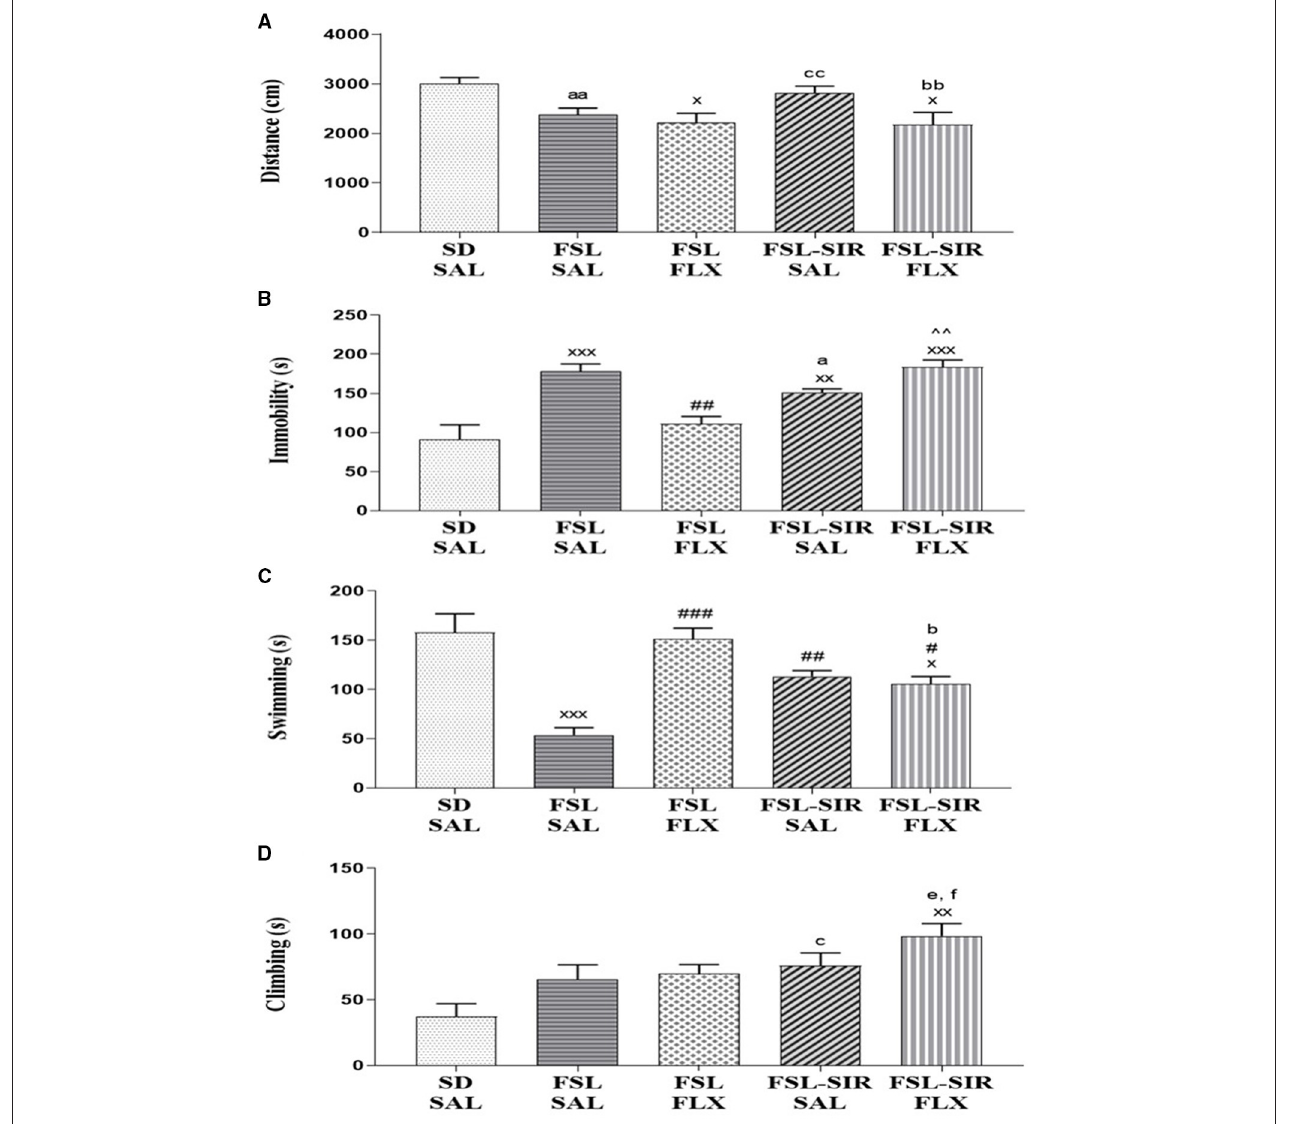
FIGURE 3 | (A) Locomotor activity measured as distance travelled in the open field test (OFT). x p < 0.05 vs. SD-SAL; aa d = 1.5 vs. SD-SAL, cc d = 0.9 vs. FSL-SAL; bb d = 1.0 vs. FSL-SIR-SAL. (B-D) Immobility and swimming and climbing behaviours as measured in the forced swim test (FST). (B) Immobility (s). xxx p < 0.0001, xx p < 0.01 vs. SD-SAL; ## p < 0.01 vs. FSL-SAL; ∧∧ p < 0.01 vs. FSL-FLX; a d = 1.1 vs. FSL-SAL. (C) Swimming (s). xxx p < 0.0001, x p < 0.05 vs. SD-SAL; ### p < 0.0001, ## p < 0.01, # p < 0.05 vs. FSL-SAL; b d = 1.5 vs. FSL-FLX. (D) Climbing (s). xx p < 0.01 vs. SD-SAL; c d = 1.2 vs. SD-SAL, f d = 1.0 vs. FSL-SAL, e d = 1.0 vs. FSL-FLX. Data were analysed using two-way ANOVA followed by Bonferroni post hoc test and Cohen’s d analysis. Data are presented as mean ± SEM. Detailed p –values in the text. FSL, Flinders’ Sensitive Line; FLX, fluoxetine; SAL, saline; SD, Sprague-Dawley; SIR, social isolation rearing.